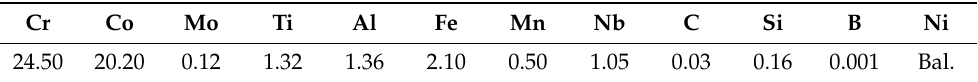
Table 1. Chemical composition of Inconel 740H superalloy, in wt.% (according to the material certificate provided by the manufacturer).